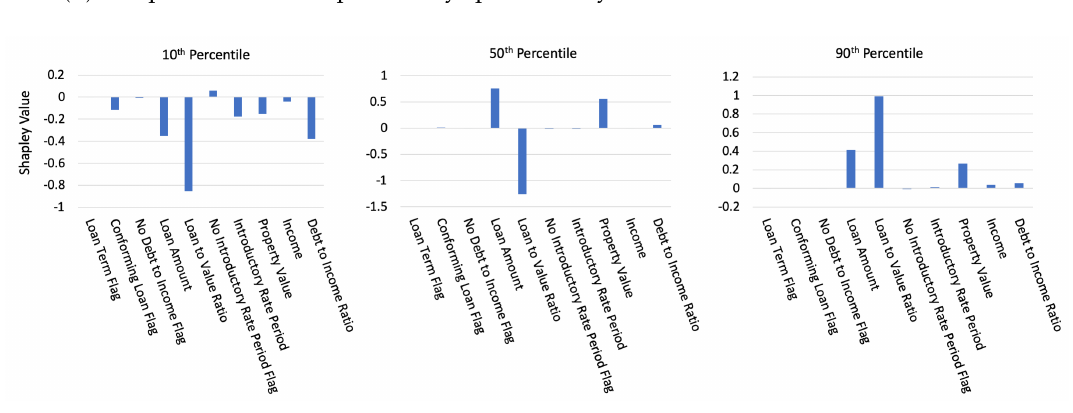
Figure 4. Tree SHAP values for three individuals across selected percentiles of g MGBM ( X ) for the mortgage test